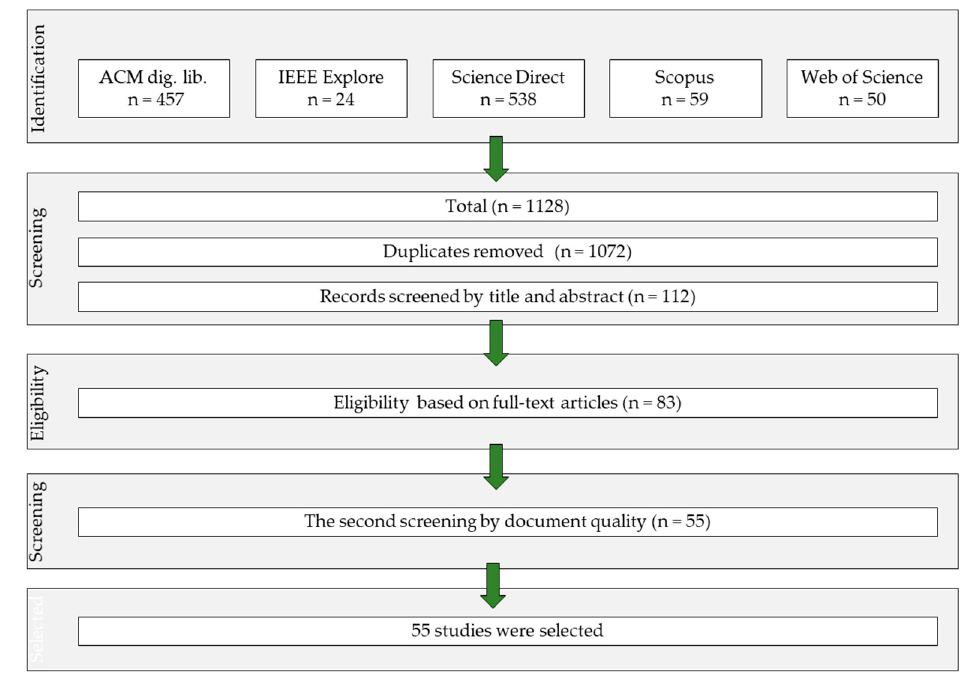
Figure 2. PRISMA flow chart and search results.